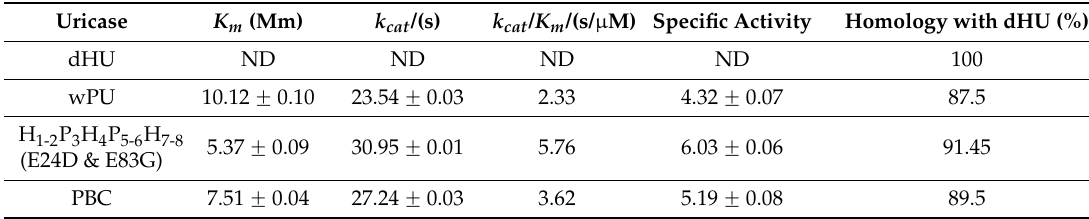
Table 1. Kinetic parameters for Uox of dHU, wPU, H 1-2 P 3 H 4 P 5-6 H 7-8 (E24D & E83G), and PBC. Uricase K m (Mm) k cat / (s) k cat /K m / (s/ µ M) Specific Activity Homology with dHU